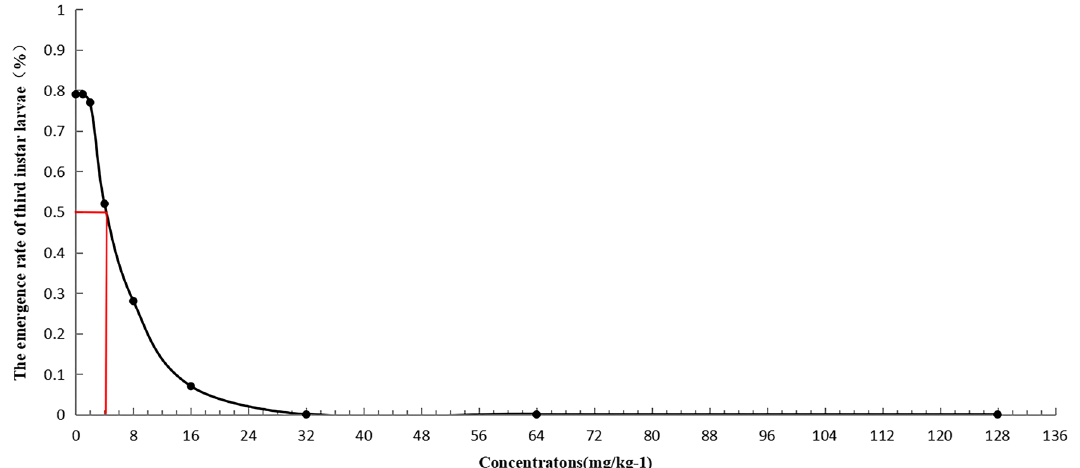
Figure 1. The survival curve and median lethal concentration (LC 50 ) of Drosophila larvae. Drosophila larvae were exposed to a range of Cd concentrations (Mean ± SD, n = 3, 175 eggs per sample). Cd concentration corresponding to 50% mortality was 4.449 mg/kg at the 95% confidence